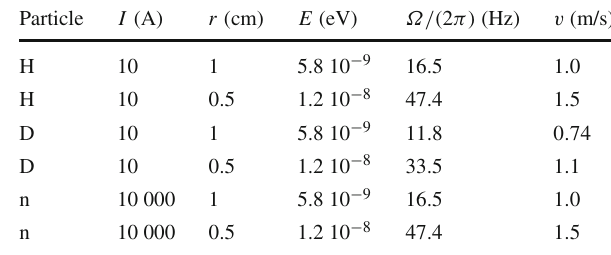
Table 1 Typical parameters (orbit radius r , energy E , rotation fre- quency Ω , velocity v ) of a particle (hydrogen atom, deuterium atom, neutron) state bound in the magnetic field of a linear current I